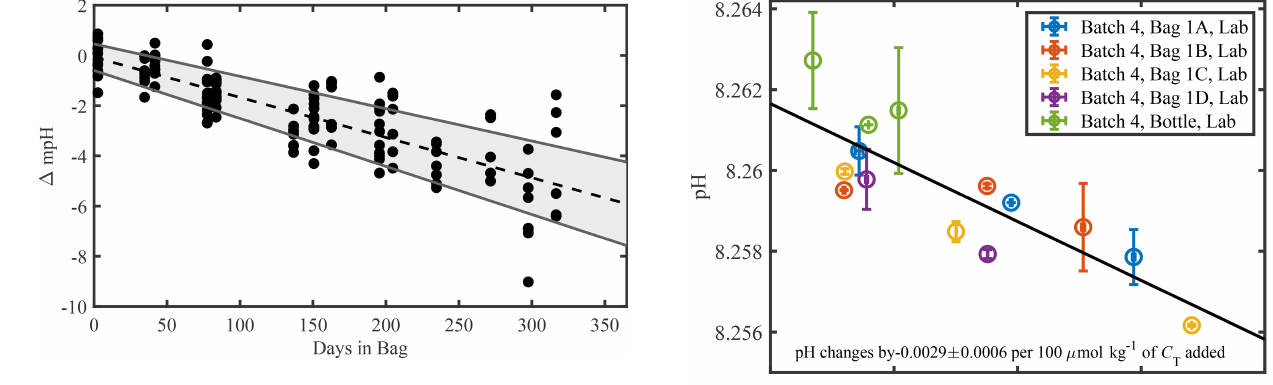
Figure 3. Combined time series of measured pH in tris buffer so- lutions. The dots represent every measurement made on a (non- damaged) bag of tris. The dotted line is the “all bags, all batches, lab or tank” regression. The grey shaded region is the observational 95% CI. The CI is intended to estimate the future pH of a tris bag (with known initial pH and an unmeasured bag specific rate of change). The upper and lower bounds are − 0.0042 and − 0.0076 pH per year, respectively.